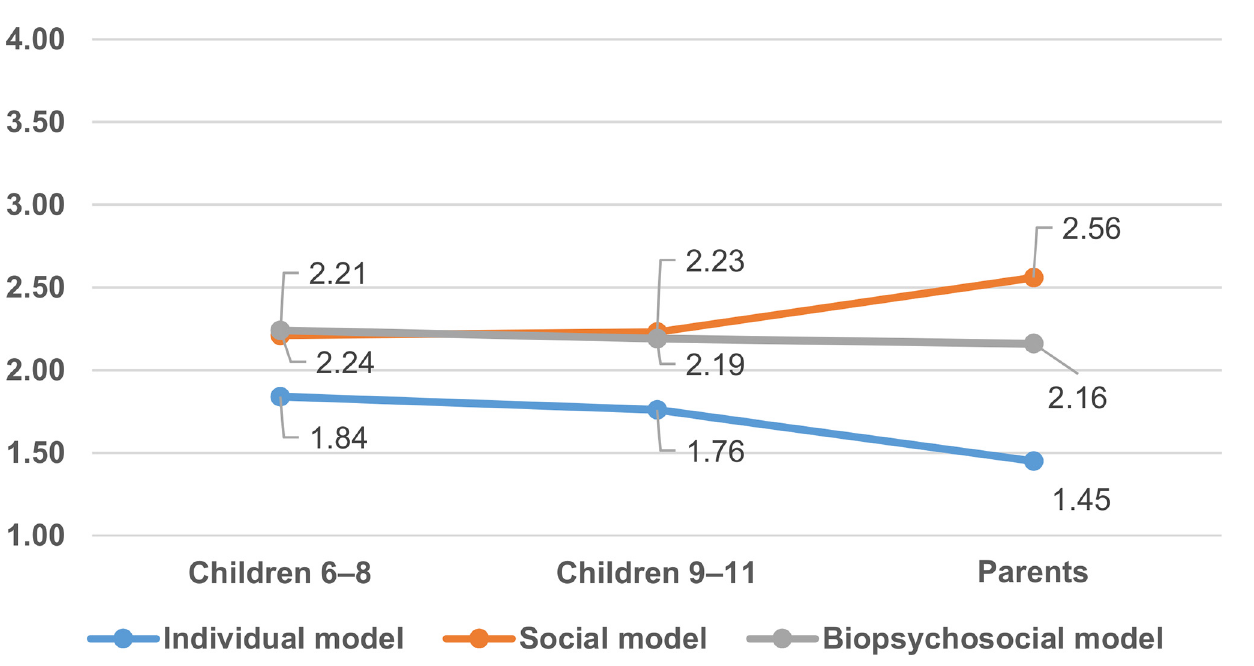
Fig 2. Disability Explanation — Closed-Ended Questionnaire. Mean frequency agreement for the three disability models by age.